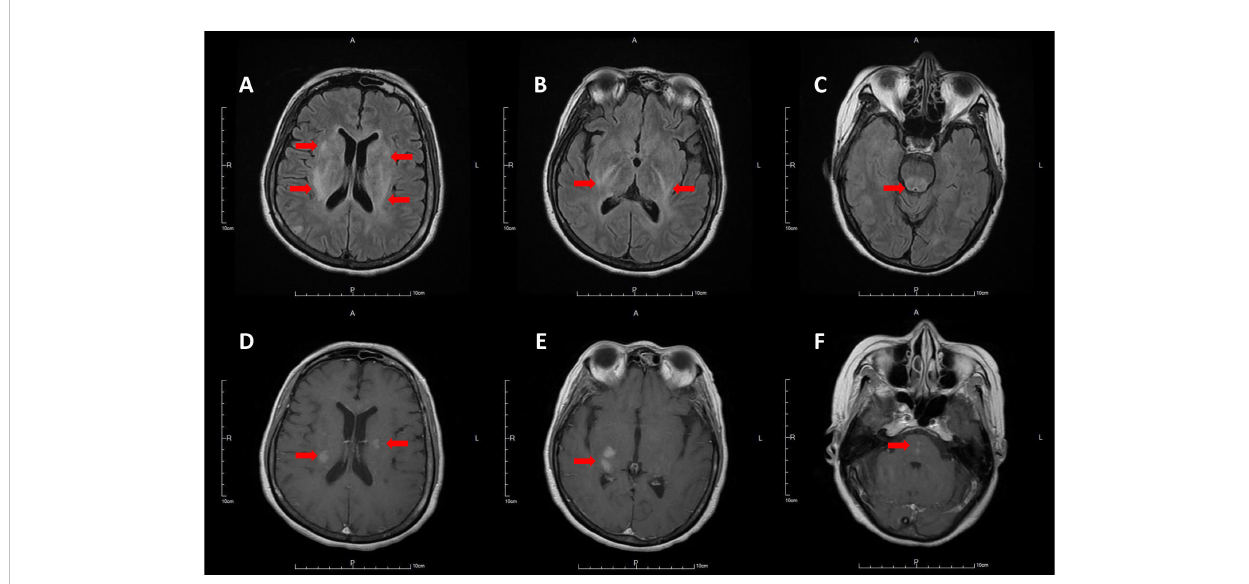
FIGURE 2 Hyperintensities involving bilateral subcortical white matter and basal ganglia (A) , posterior limb of internal capsule (B) , brainstem (C) on T2 fl uid attenuated inversion recovery brain MRI, with contrast enhancement on post-contrast T1-weighted images (D – F)